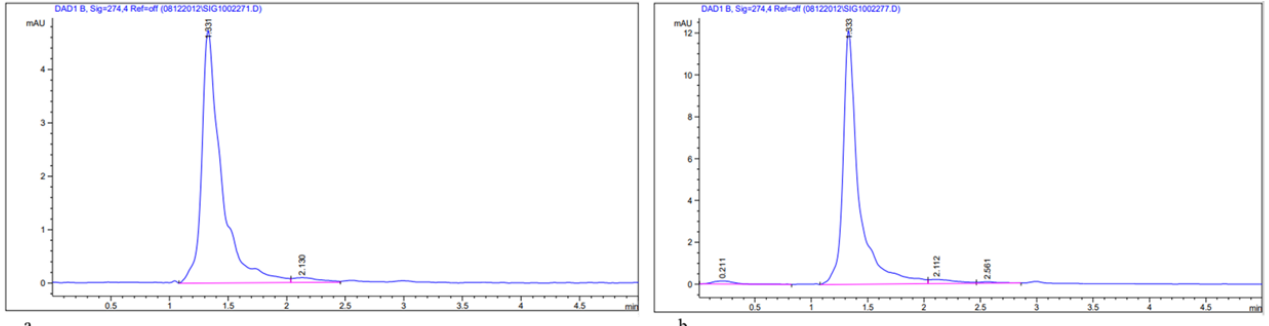
Figure 6. HPLC chromatogram of bioactive compound (Quercitin 3- β - D -glucoside) extracted from young leaves of Acacia species; ( a ) Standard compound, Quercitin 3- β - D -glucoside; ( b ) A. johnwoodii ; ( c ) A. origena ; ( d ) A. etbaica .